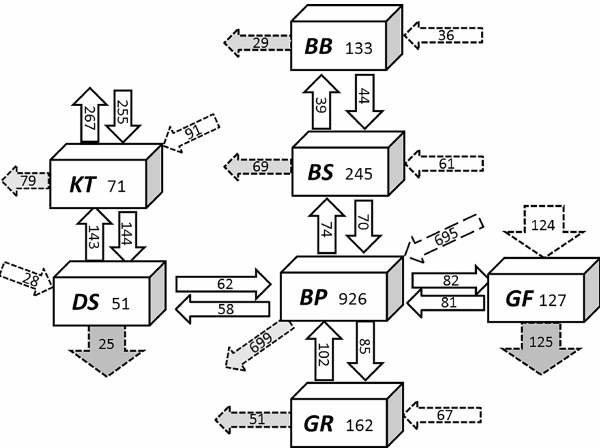
Figure 11. The same as Fig. 9, but for